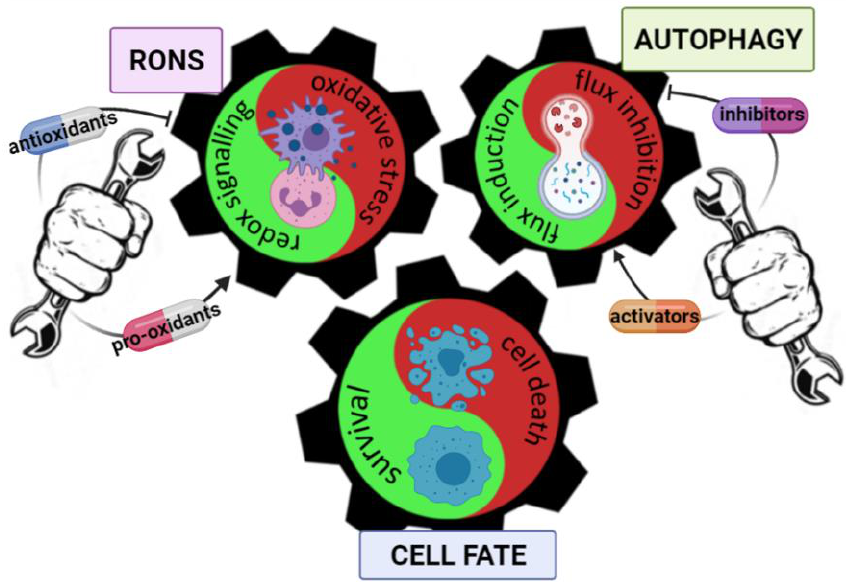
Figure 2. The mechanistic cross-talk between oxidative stress and autophagy in melanoma cell fate.